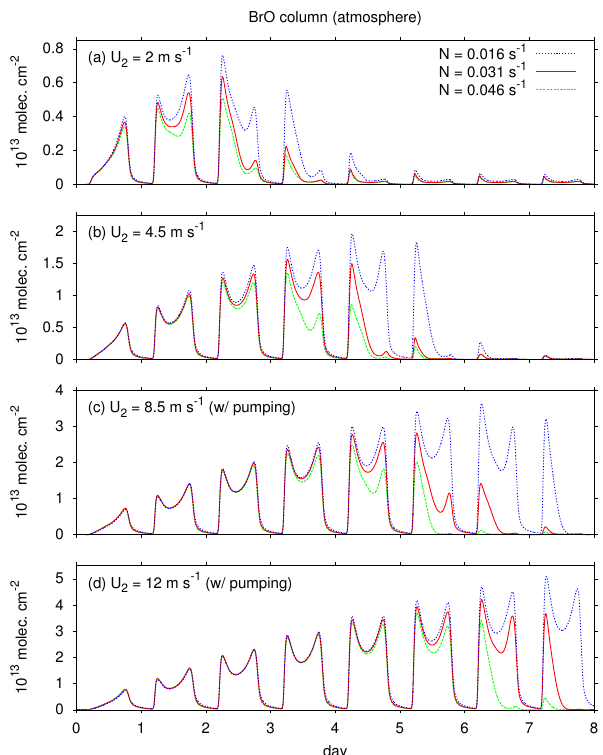
Fig. 16. Simulated column amounts of BrO in the atmosphere with U 2 assigned at (a) 2ms − 1 , (b) 4.5ms − 1 , (c) 8.5ms − 1 , and (d) 12ms − 1 . A sensitivity of the simulated BrO columns to the choice of N (0.016s − 1 , dotted blue lines; 0.031s − 1 , solid red lines; and 0.046s − 1 , broken green lines) is also